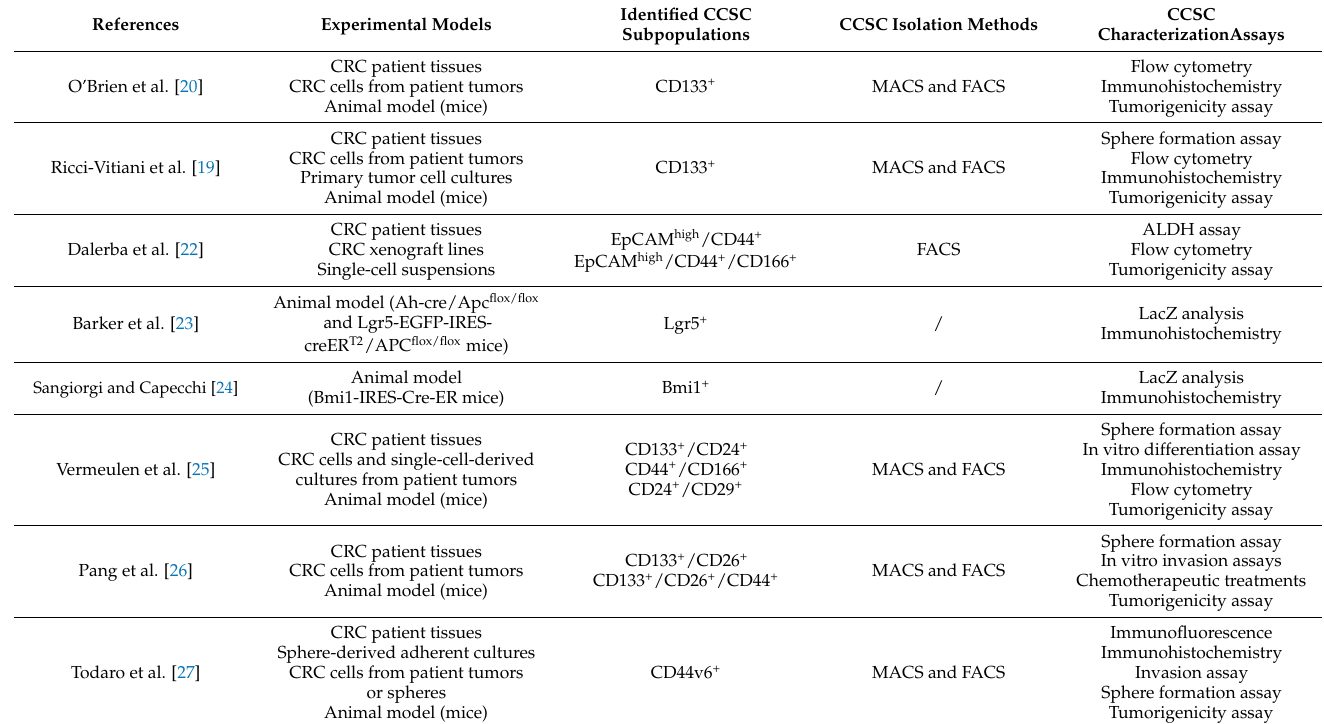
Table 1. Experimental models, markers and CCSC isolation and characterization methods used in the first publications identifying CSCs in